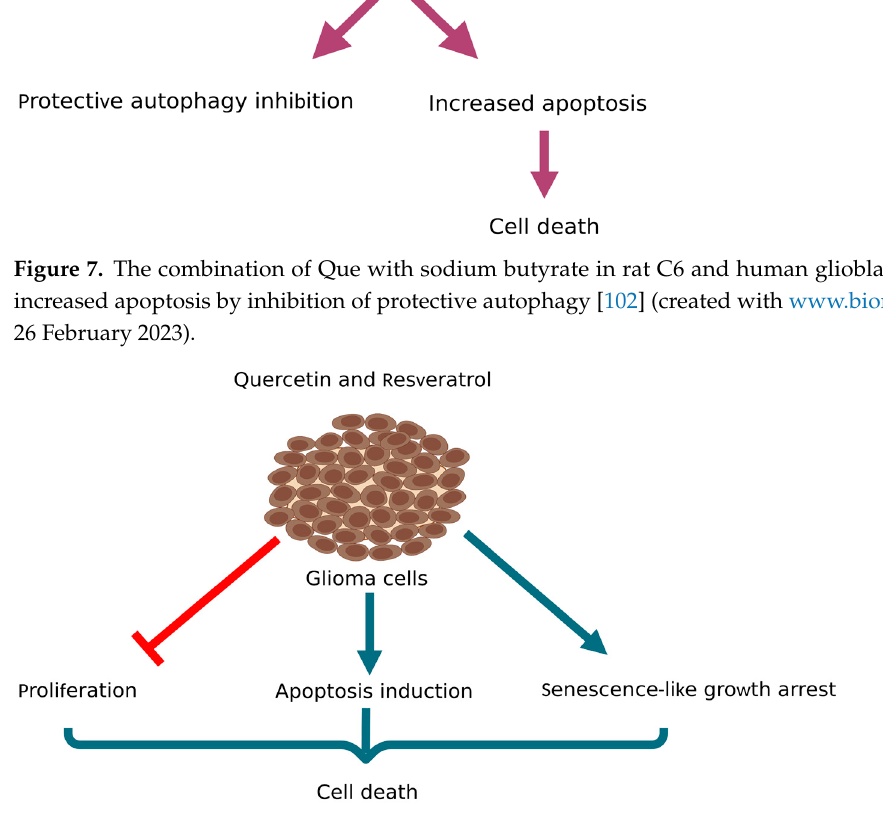
Figure 8. Co-administration of Que with resveratrol in rat C6 glioma cells, human U87-MG, and U138-MG glioma cells line inhibited c ell proliferation, triggered apoptosis and induced senes- cence-like growth arrest [107] (created with www.biorender.com; 26 February 2023